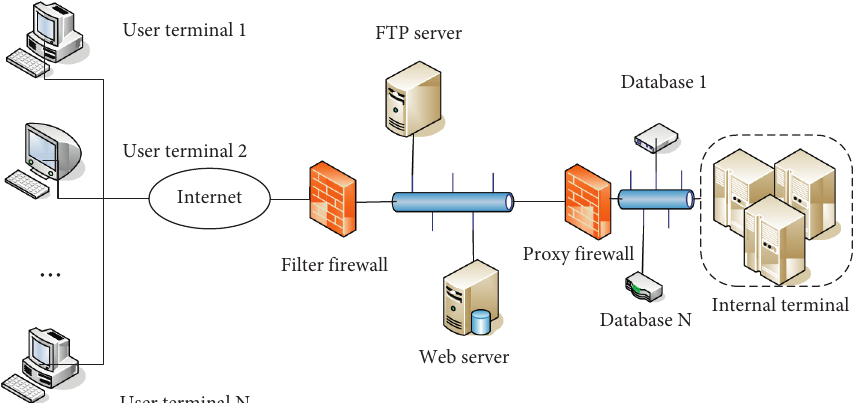
Figure 1: Public library network topology.